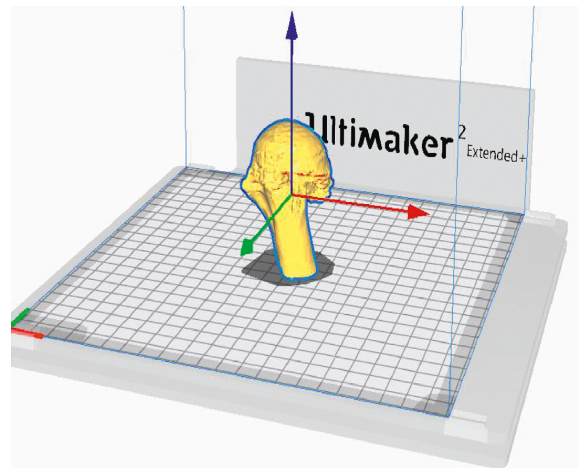
Figure 5: Final planning of the 3D model of PHF ready for